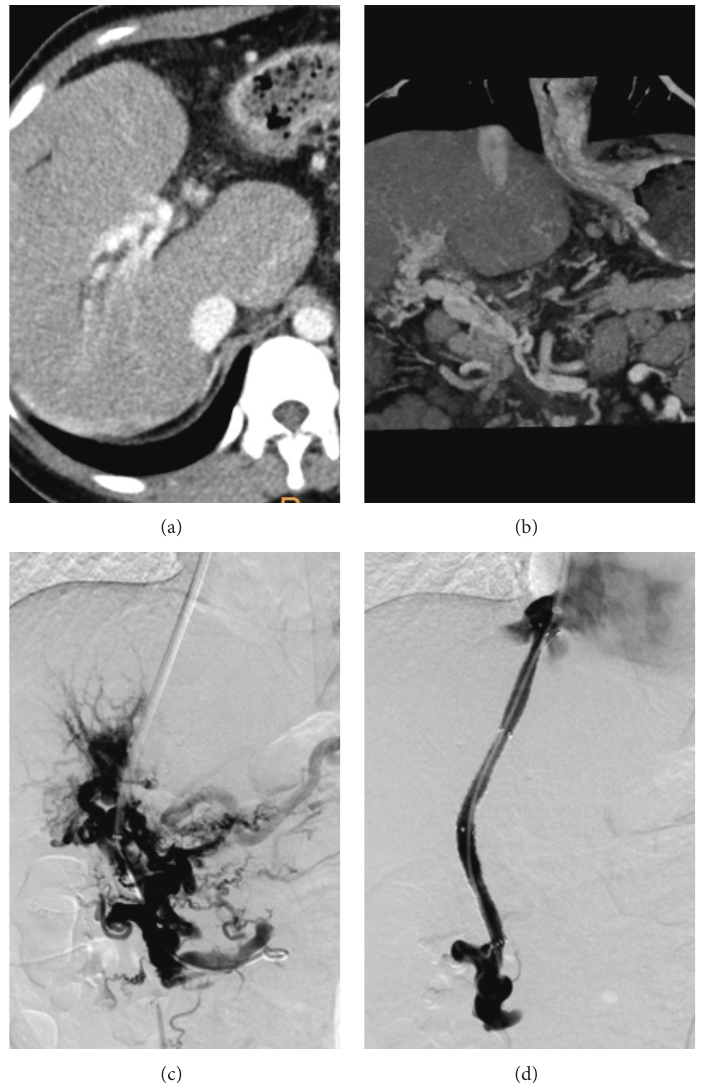
Figure 2: TIPS placement in a 21-year-old woman with portal cavernoma. (a-b) CT scan shows the obliteration of the original main portal vein and superior mesenteric vein, as well as the periportal collateral veins supplying the intrahepatic veins. (c) Direct portal venogram after catheterization into the portal vein reveals only collateral vessels and varices. (d) Final portal venogram obtained after TIPS placement demonstrates a good decompression of the portal venous